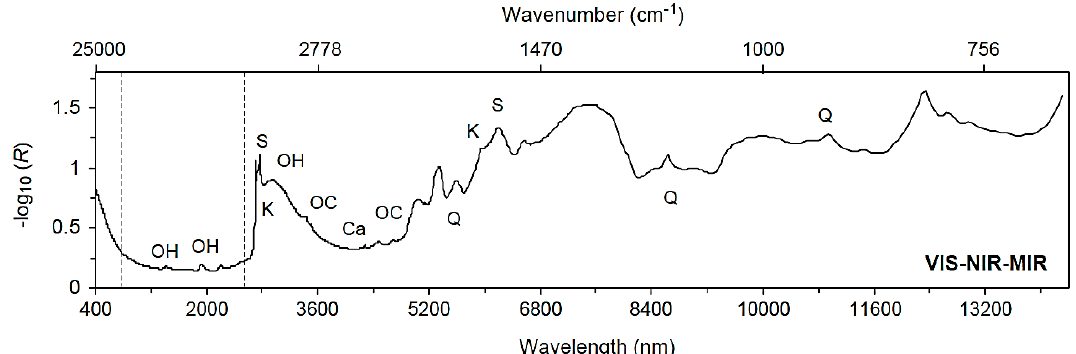
Figure 2. Vischarra Rossel (2006). Soil dominant components and absorption peaks for the VIS-NIR-MIR region: quartz (Q) as sand, organic compounds (OC), calcite (Ca), kaolinite (K), smectite (S), and (OH) characteristics of mineral water, and lattice.